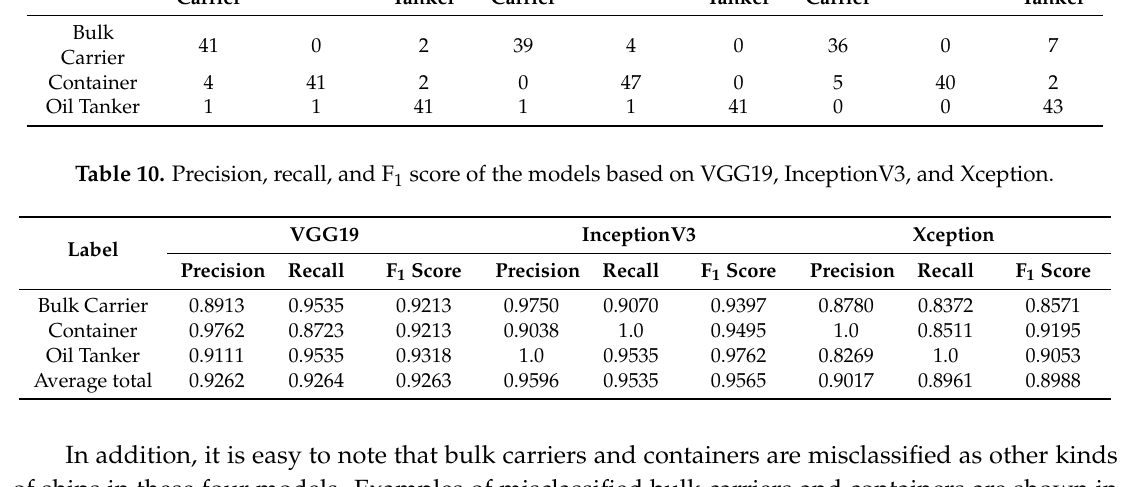
Table 9. Confusion matrix of the model based on VGG19, InceptionV3, and Xception.